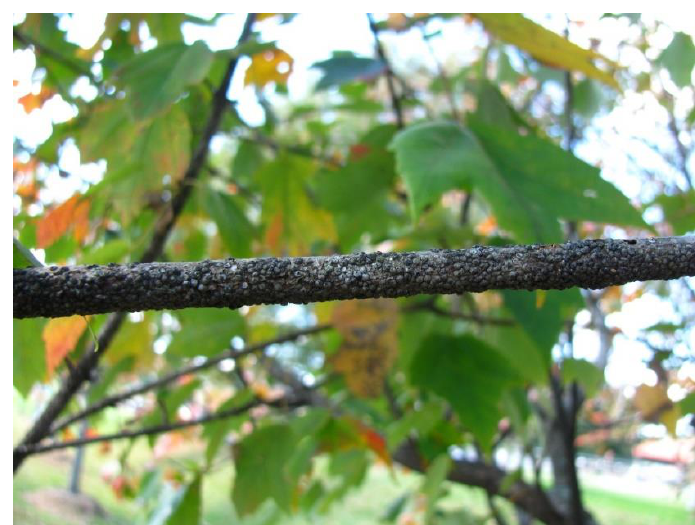
Figure 2. Red maple ( Acer rubrum ) branch heavily infest with gloomy scale ( Melanaspis tenebricosa ). Photo: Elsa Youngsteadt, North Carolina State University. The small bumps covering the bark are scale tests. See Dale, A.G., Frank, S.D., 2014. Urban Warming Trumps Herbivore Enemies. Bull. Ecol. Soc. Am. 95, 252–256 for additional images.